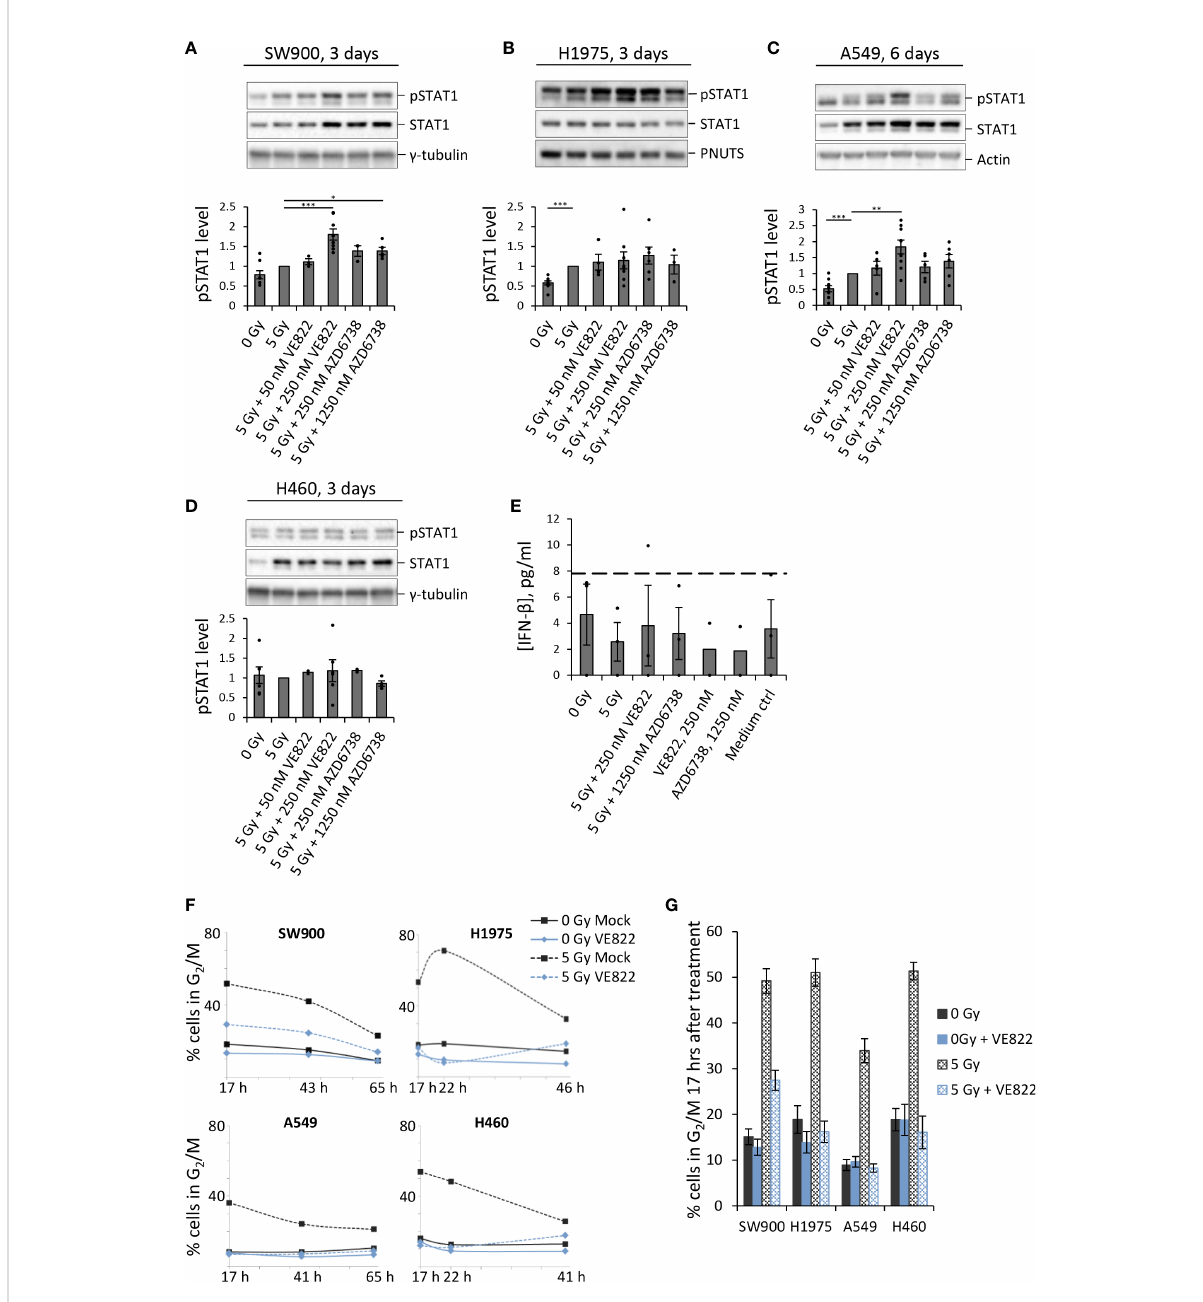
FIGURE 3 ATRi abrogates radiation-induced G2 checkpoint arrest in four human lung cancer cell lines, and gives increased IFN response in three of these. (A – D) Immunoblots for indicated NSCLC cell lines after treatment with IR and ATRi. Bar charts show pSTAT1 levels relative to loading controls and normalized to 5 Gy. (Results for A549 at three days after treatment and at six days for the other cell lines are shown in Supplementary Figure S2). g -tubulin, PNUTS and pan-actin were used as loading controls. (E) ELISA of IFN- b in H460 cells treated and analyzed as in Figure 2H. (The zero values are from an experiment where all IFN readings were equal to or lower than the lowest value of the standard curve). (F) Proportion of cells in G2/M phase after treatment with IR and 250 nM VE822. The corresponding DNA histograms are shown in Supplementary Figure S3. (G) Bar-plotted quanti fi cation of G2/M proportions from three independent experiments performed as in (F) , at 17 hours after